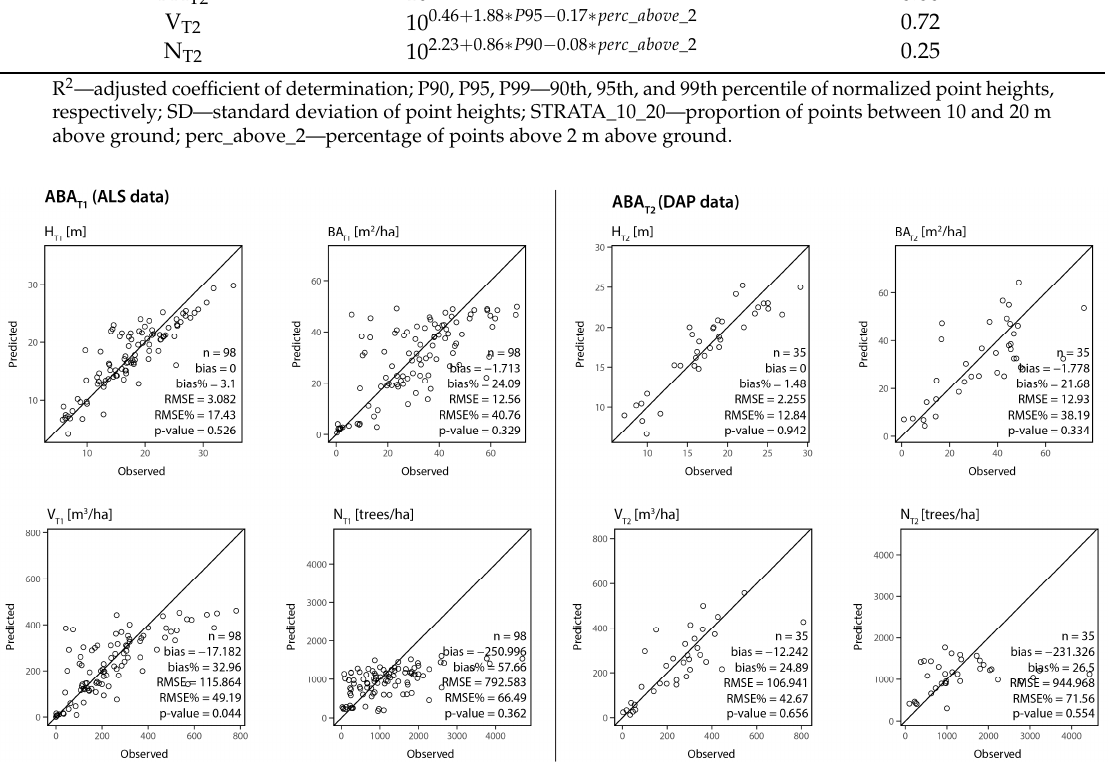
Figure 4. Observed versus predicted values for top height (H), basal area (BA), total volume (V), and stem density (N). Variables denoted with T1 were modeled using ALS data acquired at T1 (2008), while T2 variables were modeled using DAP data from T2 (2015).